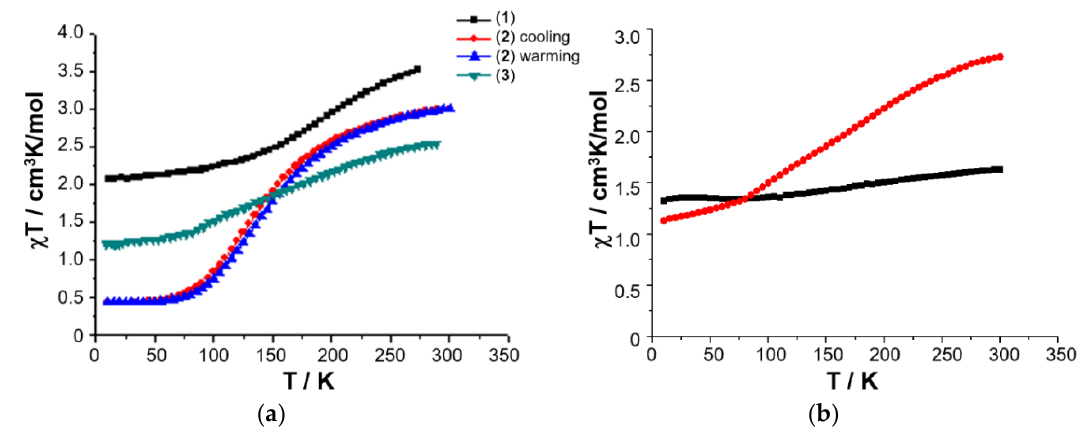
Figure 6. Temperature-dependence of the χ T product for 1 – 3 ( a ), and variable temperature χ m T of solid sample of [FeL 1C18 ]BF 4 , 3 (red circles), and freeze-dried sample of [FeL 1C18 ]BF 4 , 3 (black squares), extracted from freeze-dried aqueous assembly of 3 ( b ). Magnetic data originally published in [50,52].